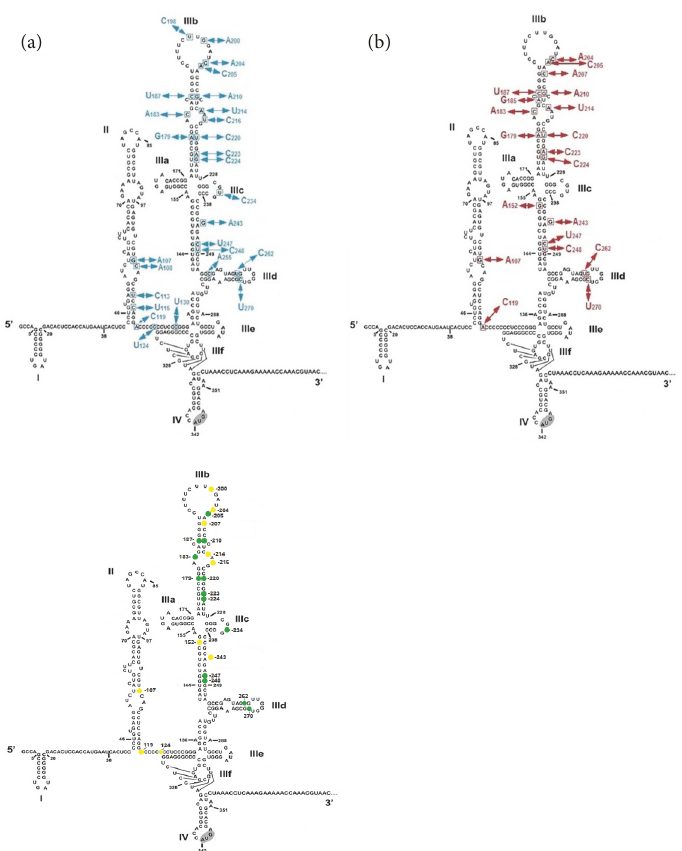
Figure 1: Nucleotide differences detected in 5’UTR sequences derived from patient PBMCs and plasma. Nucleotide changes in PBMC- derived IRES sequences (n=225) are indicated in blue while nucleotide changes in plasma-derived IRES sequences (n=225) are indicated in red.Similarities innucleotidefrequencyvariation between PBMCand plasma-derived samples arerepresentedin green dots whiledifferences are represented in yellow dots. Structural domains are indicated in Roman letters (I-IV). The start codon AUG is highlighted in stem-loop domain IV. Substitution sites are indicated as squares and arrows indicate mutations described in the text. Nucleotide sequence and putative secondary RNA structure of the 5’UTR [nt. 1-383 genotype 1b (GenBank, AJ238799.1)] was adapted from Honda et al.